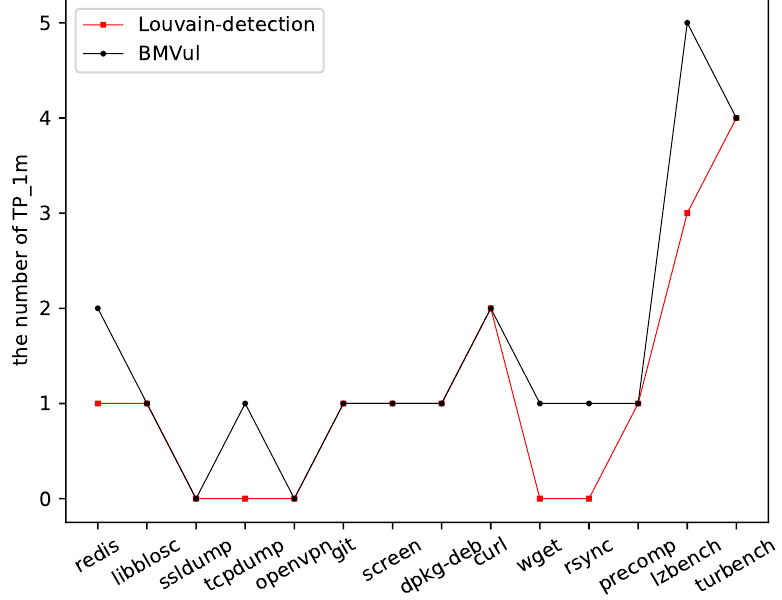
Figure 3. The comparison of TP 1 m .